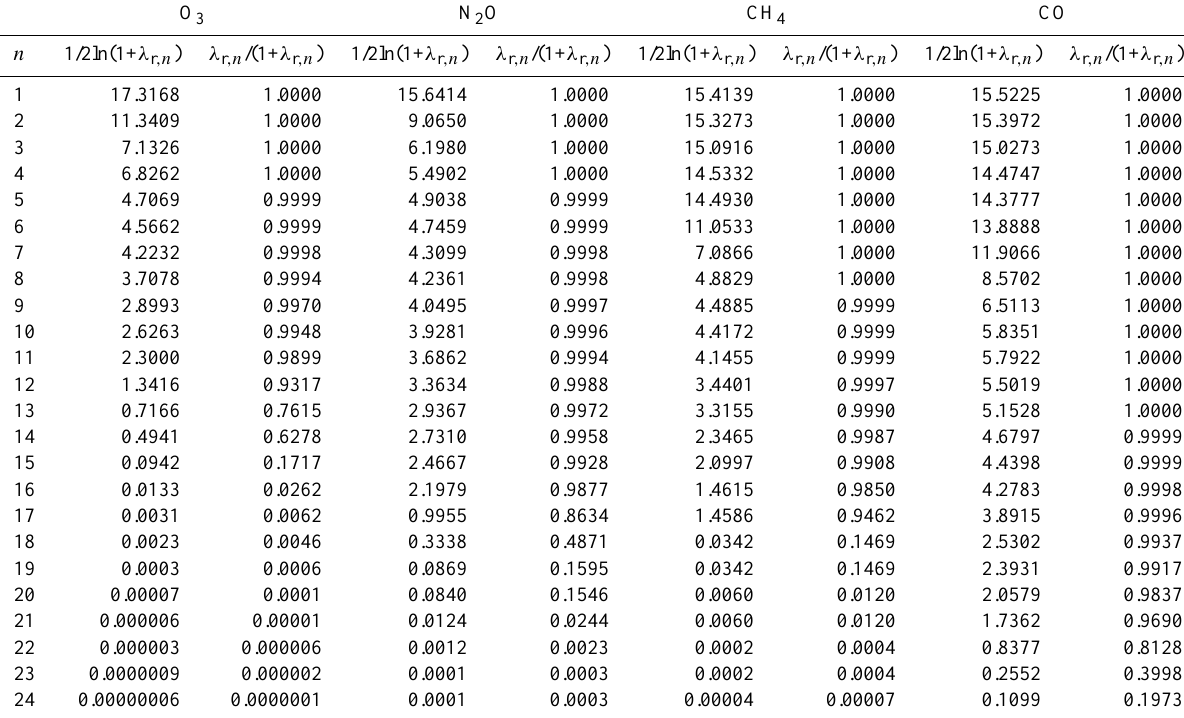
Table 2. Evolution of 1/2 ln (1+ λ r ,n ) and λ r ,n / (1+ λ r ,n ) for the largest 24 eigenvalues λ r ,n of the Kozlov information matrix P r , for O 3 , N 2 O, CH 4 and